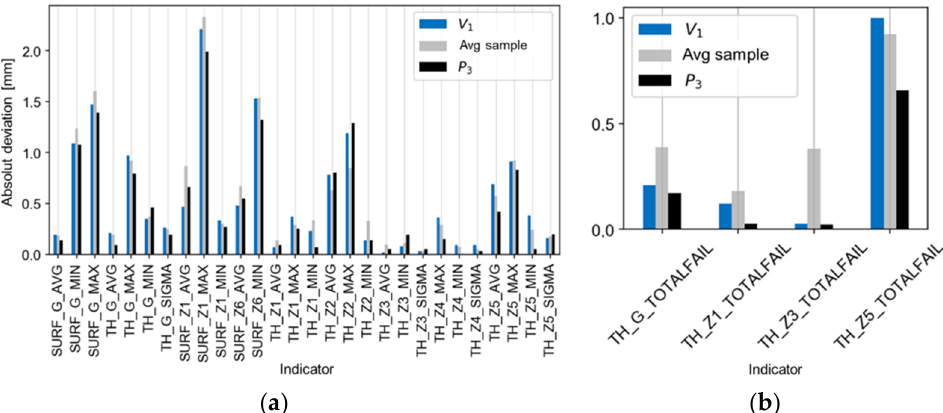
Figure 15. Comparison of the absolute deviations of the results of the V1 trial with the absolute best and average results of the experiment for the indicators of ( a ) deviation and of ( b ) tolerance.